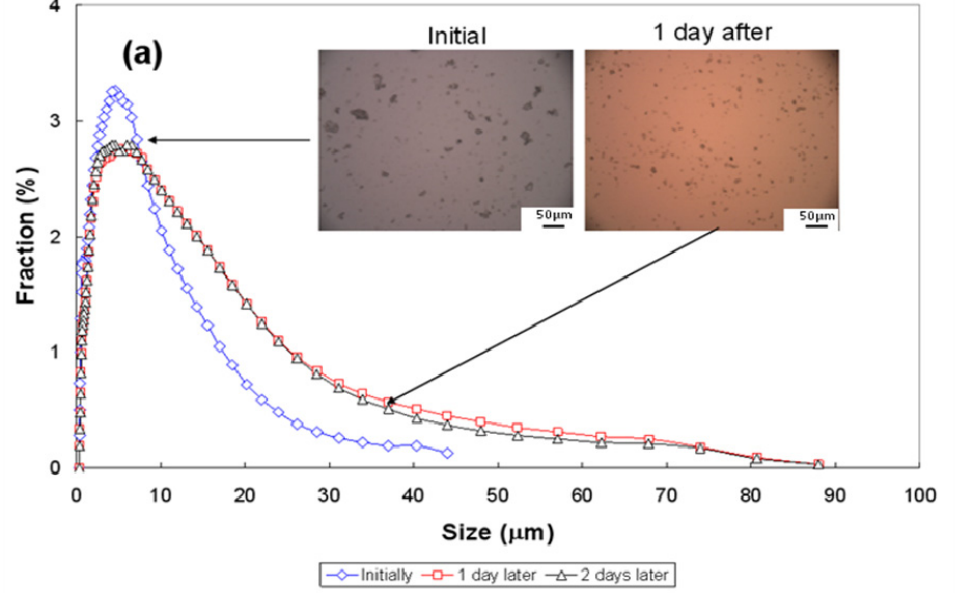
Figure 6. Particle size distribution of kaolinite at pH~7. ( a ) 1MLB; ( b )